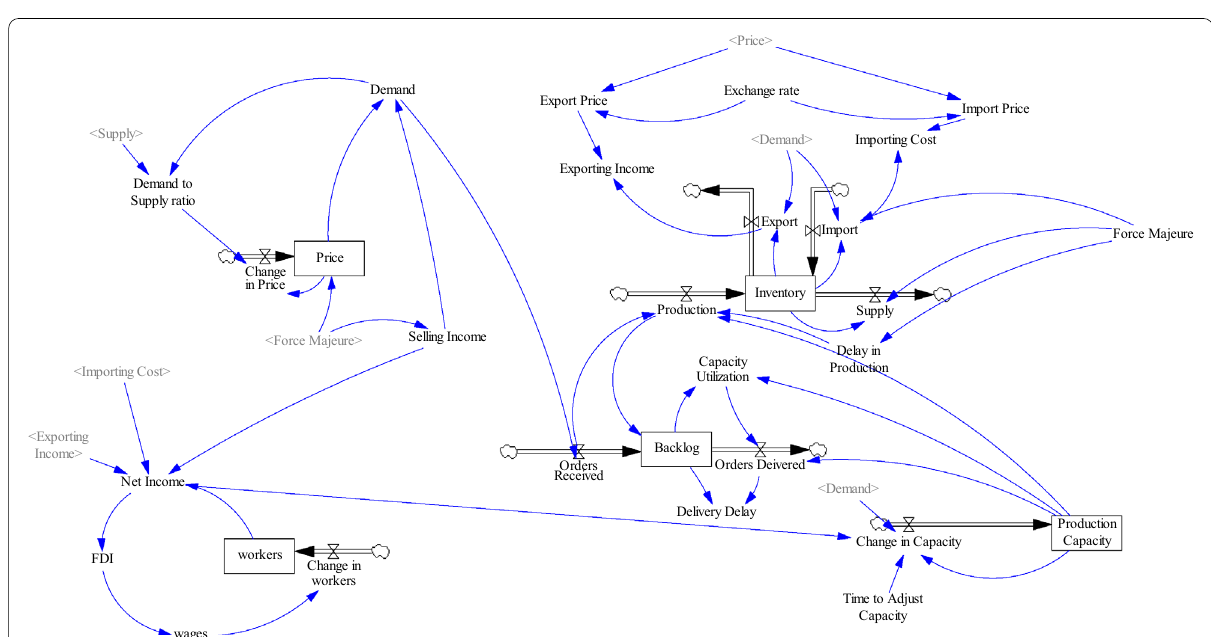
Fig. 7 stock-flow diagram